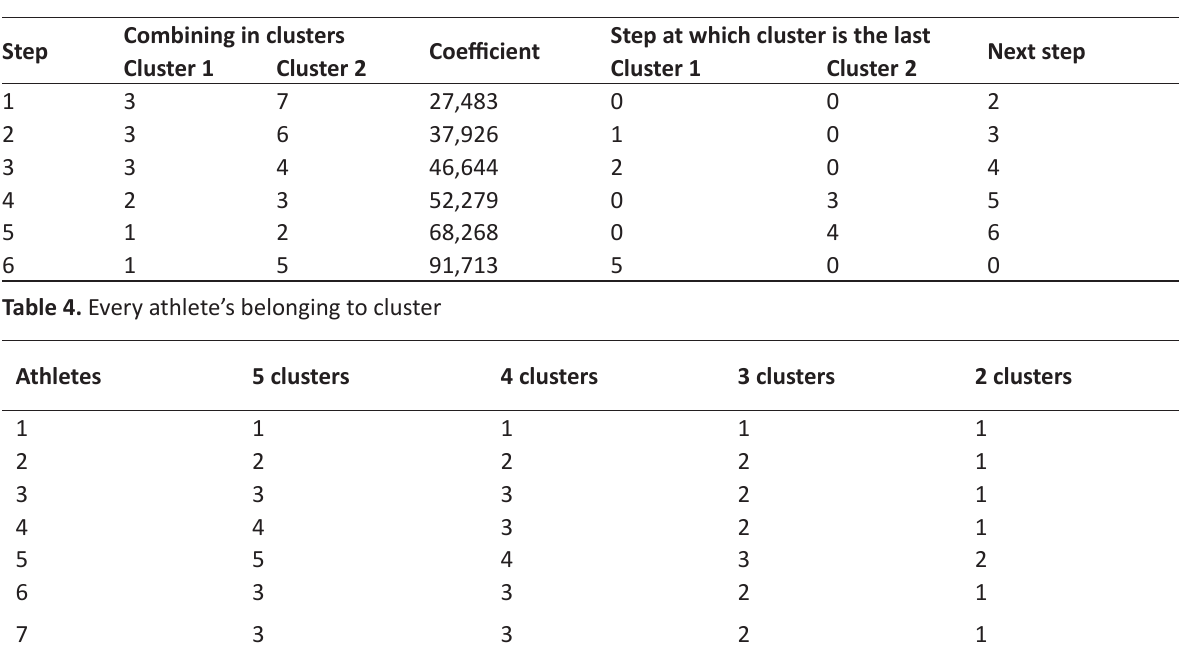
Table 3. Fragment of agglomeration order in cluster analysis of basketball players’ testing indicators